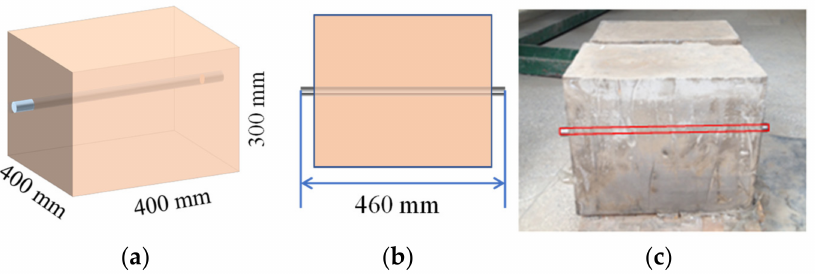
Figure 2. The dimension of specimens for guided wave testing. ( a ) Side view; ( b ) Top view; ( c )